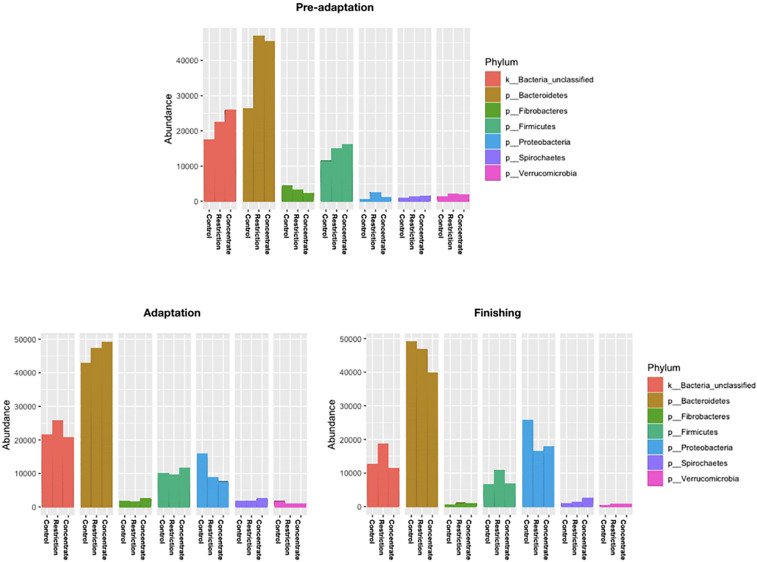
Relative abundance of the top seven phylum of ruminal bacterial communities observed in all cannulated Nellore cattle during pre-adaptation (day 5), adaptation (day 16), and finishing (day 27) in all sampling periods. Samples represent on average ≥ 1% of the total sequence abundance recovered from each animal.